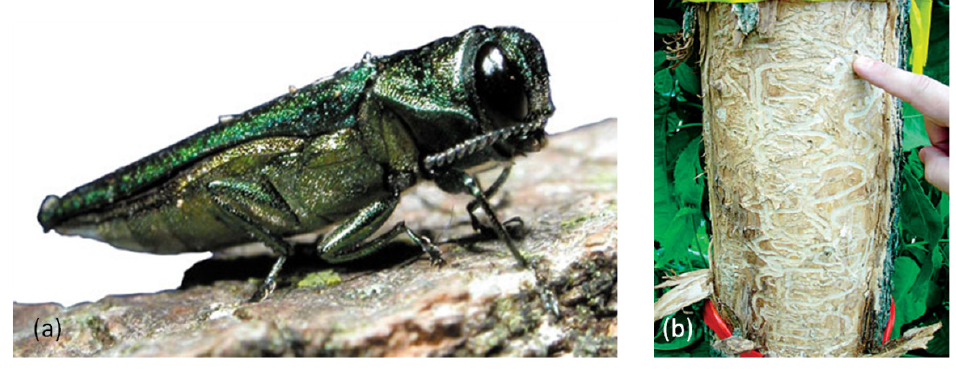
Figure 1. Pictures of adults ( a ) and galleries ( b ) of Agrilus planipennis . (Sources: Wikimedia